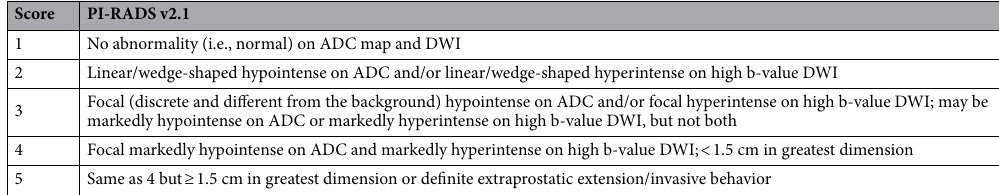
Table 2. Scoring system of diffusion-weighted imaging for assessment of transition zone and peripheral zone in PI-RADS v2.1.